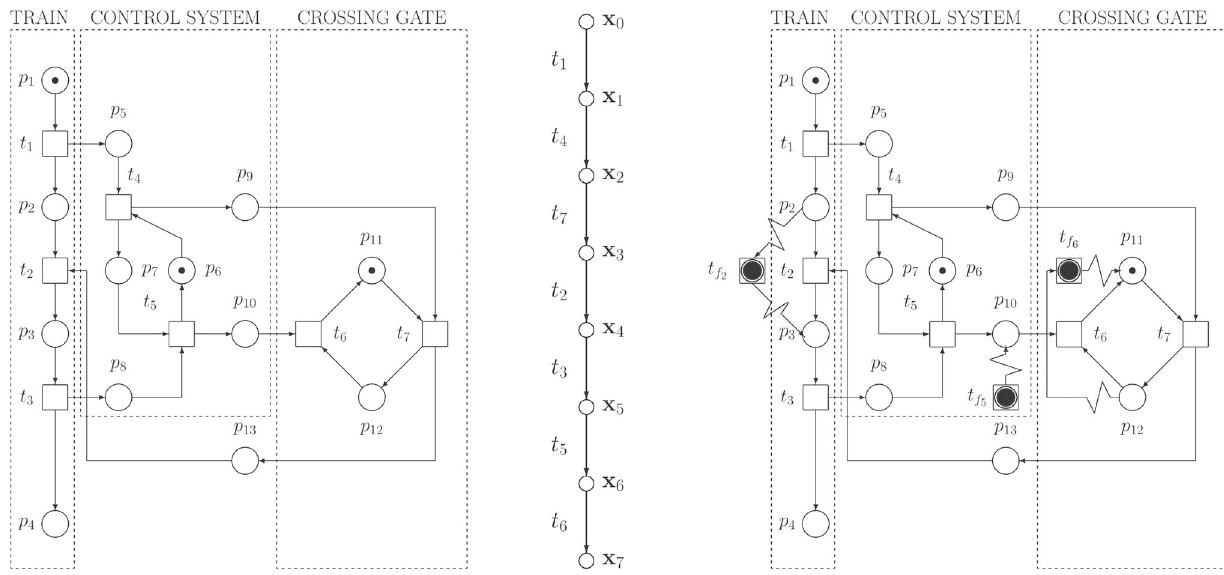
Fig. 2 The PN model of the failure-free case together with its RT (left) and the PN model with three potential failures (right)